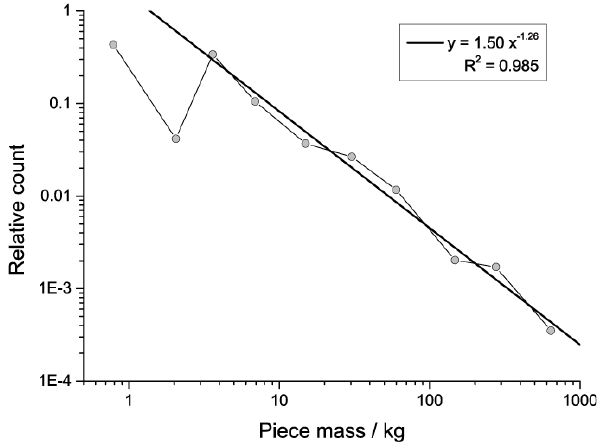
Figure 7. Scaling distributions of piece mass for LWD in the See- blibach (4) and Ursprung (11) (see Table 1), as examples for distri- butions observed in the Swiss mountain streams (Rickli and Bucher, 2006). Distributions both for material locked in log jams (square symbols) and for all material (circles) stored in the channel are